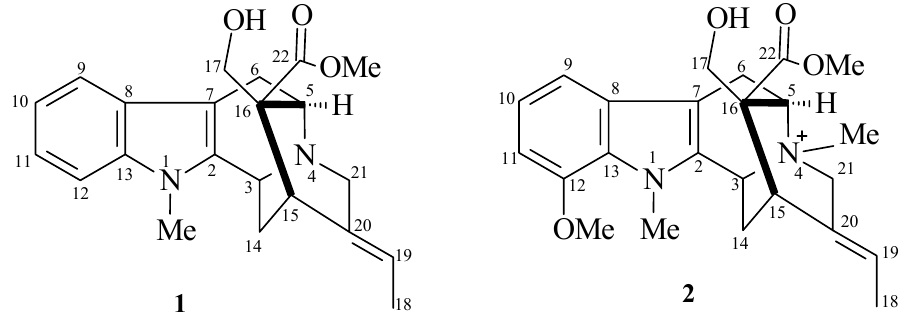
Figure 1. Structure of the isolated alkaloids: voachalotine ( 1 ) and 12-methoxy- N methylvoachalotine ( 2 ).